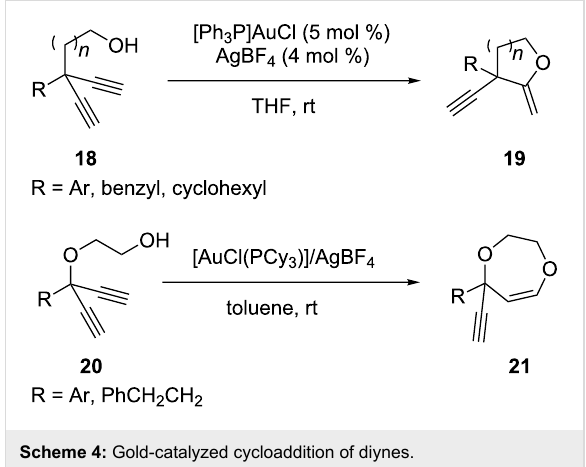
Scheme 4: Gold-catalyzed cycloaddition of diynes.